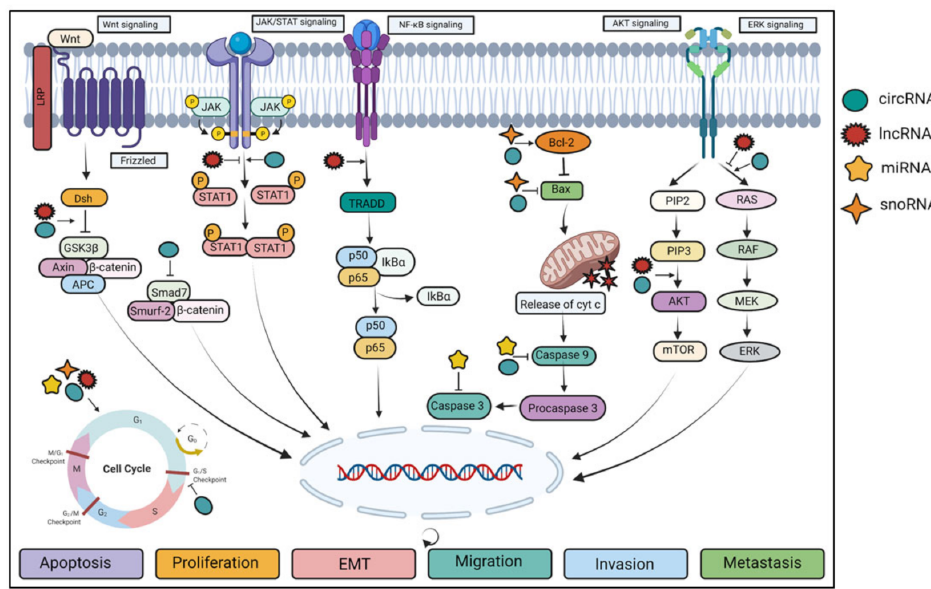
Figure 2. Role of ncRNAs in regulating different signaling pathways in